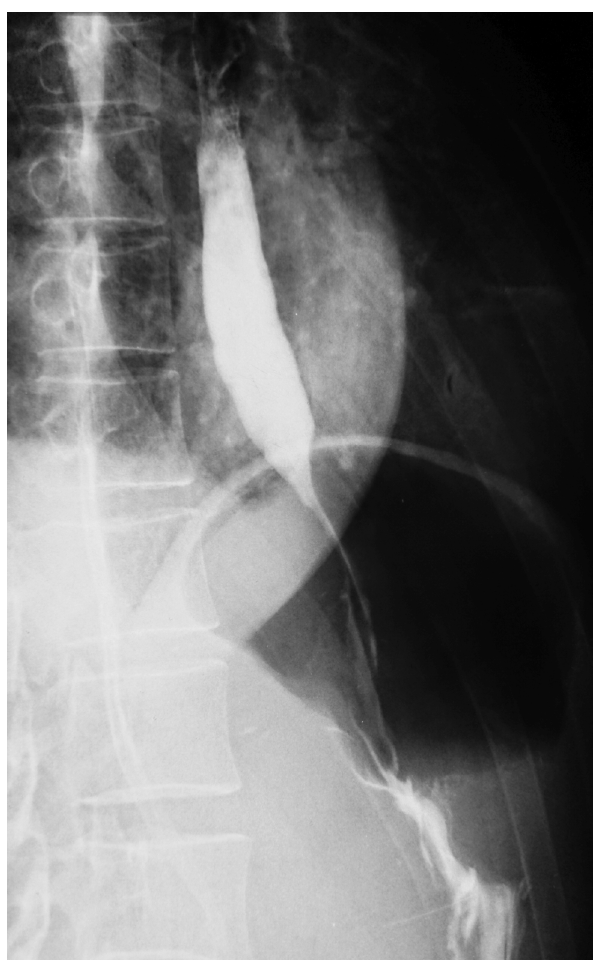
Fig. 2. The patient underwent sequential balloon dilations with- out treatment response. Fluoroscopy with barium revealed mild dilatation of the oesophagus with distal smooth, short-segment tapering.